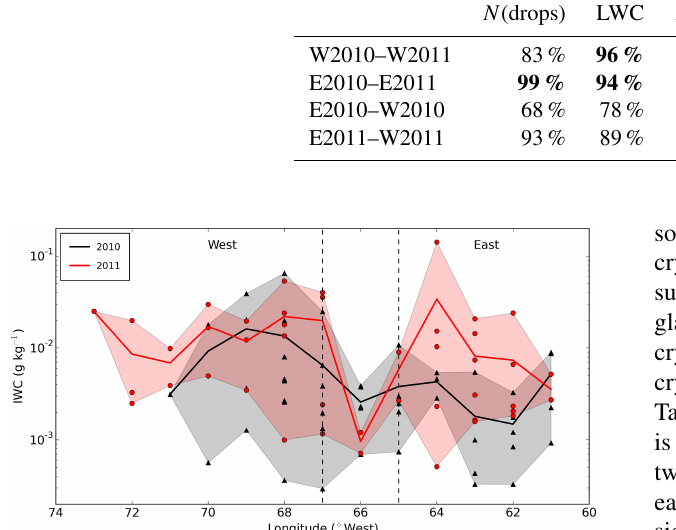
Table 2. Statistical significance of the differences between either year on either side of the peninsula as obtained from the t test performed for the four cloud variables and the aerosols (see text for details). Values greater than 90% are highlighted in bold. N (drops) LWC N (ice)